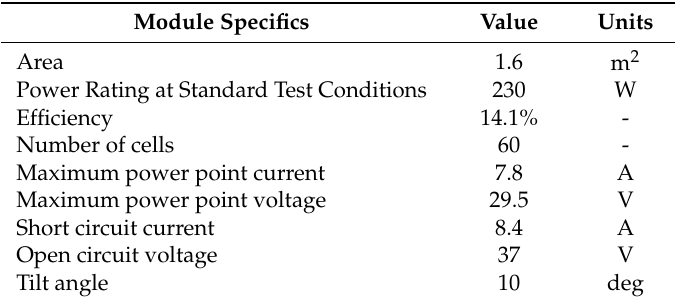
Figure 1. Heating system layout. Table 1. Technical specifics of the photovoltaic (PV) modules.